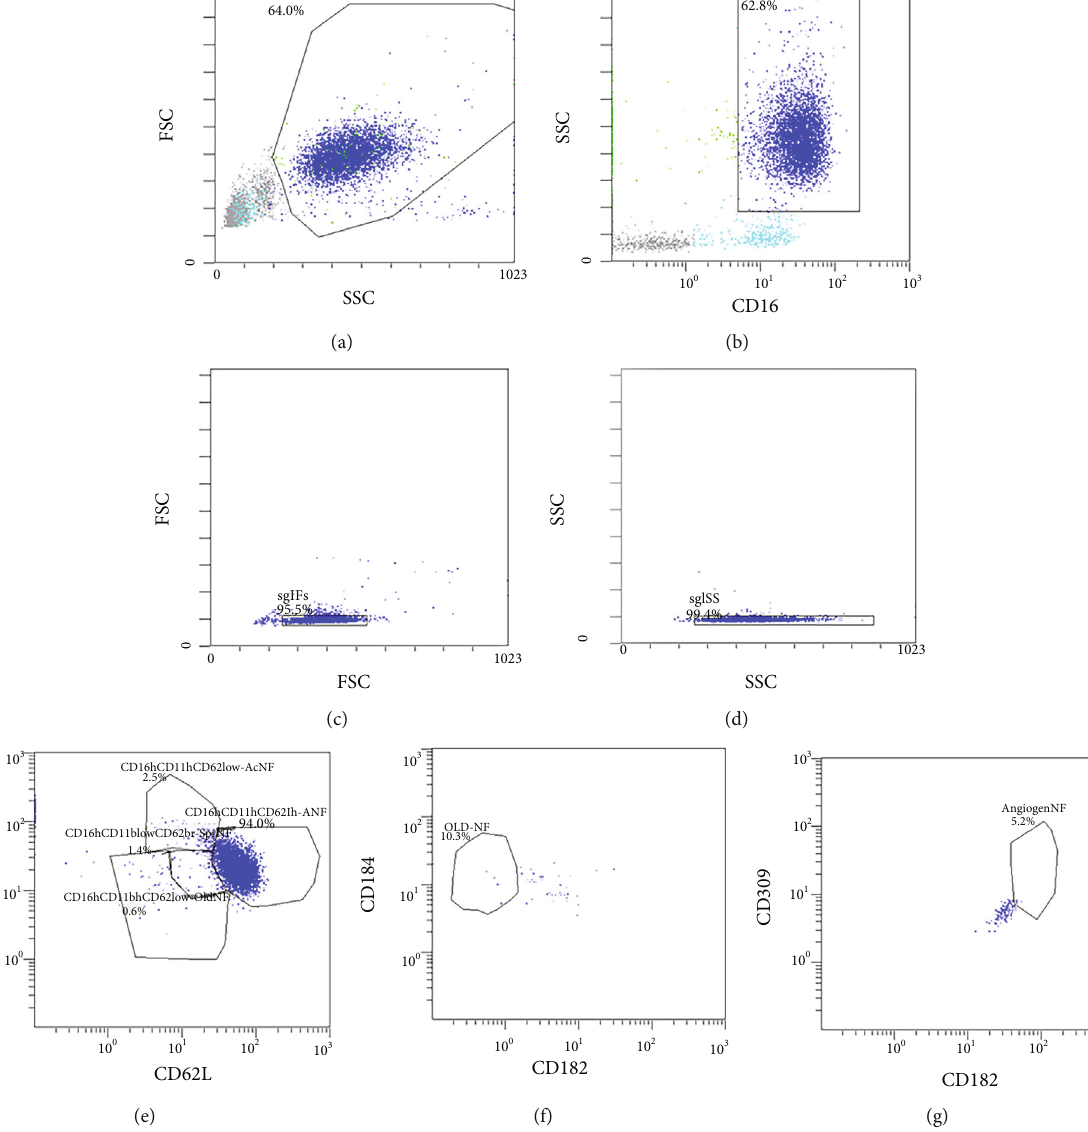
Figure 1: Gating strategy of fl ow cytometry. Sequential gating strategy for the identi fi cation of neutrophil subpopulations. Granulocytes were gated based on Forward Scatter (FSC) and Side Scatter (SSC) ( а ). Furthermore, CD16 + cells were identi fi ed, and single cells were gated based on FSC Time-Of-Flight and FSC Integral (c) and SSC Time-Of-Flight and SSC Integral (d). Identi fi cation of mature neutrophil subpopulations depending on CD11b and CD62L expression (CD11b hi CD62L hi ) (e). Identi fi cation of aging neutrophils by the expression of CD184 and CD182 (f). Identi fi cation of VEGFR2 hi -neutrophils by the expression of CD309 and CD182